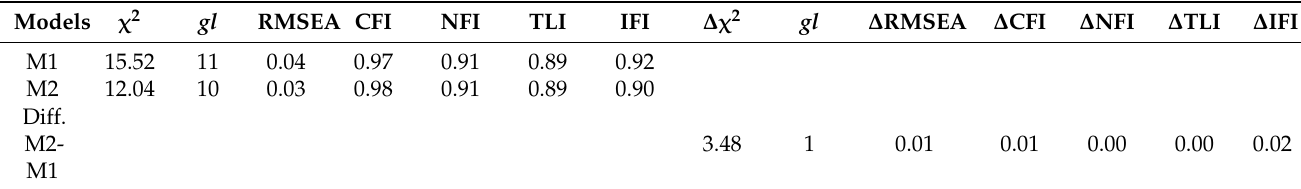
Table 7. Fit indices for structural equation models by aggregated data at the team level of analysis (N = 177 teams). Models χ